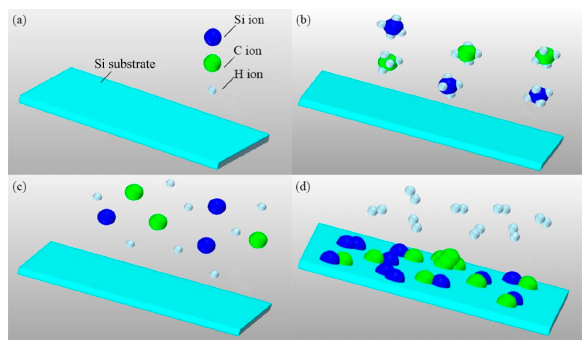
Figure 2. The sketch of preparation process of nanocrystal 3C-SiC thin film using Plasma Enhanced Chemical Vapor Deposition (PECVD). ( a ) The Si substrate; ( b ) SiH 4 and CH 4 are inputted into the reaction vessel; ( c ) The reaction gases are decomposed into the ions such as H + , Si + and C + ; ( d ) The ions combine to form neutral species, such as SiC, H 2 ,Si and C, which are adsorbed on the surface of the Si substrate. The H 2 gas is pumped out of the vessel with other unreacted gas.